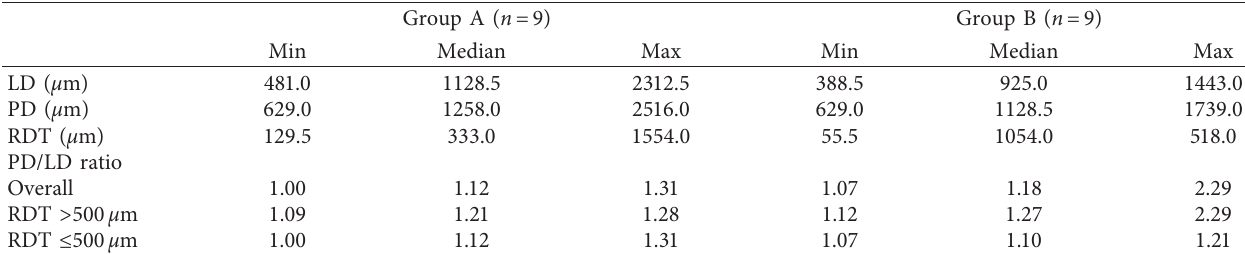
Figure 2: The estimated remaining dentin thickness (RDT), lesion depth, and silver penetration depth for each sample determined from micro-CT analysis ( N � 18). Table 1: The minimum (Min), median, and maximum (Max) values of each variable in groups A and